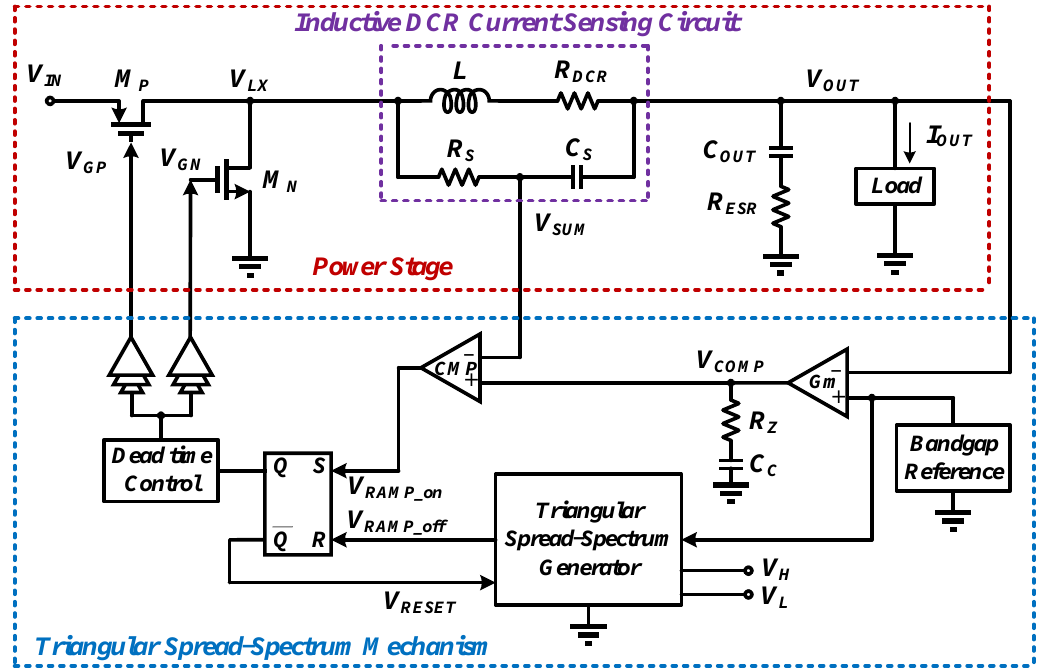
Figure 5. Block diagram of the proposed DC-DC buck converter.